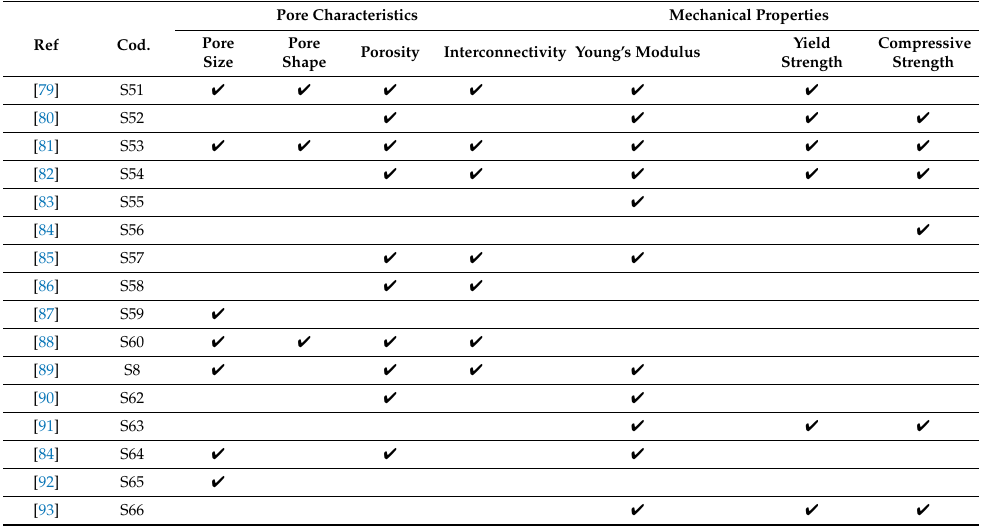
Table 2. Studies selected in the systematic search according to information related to bone